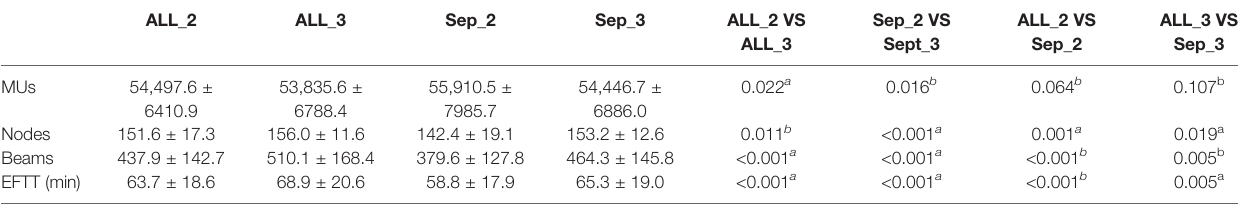
a Comparison by paired samples t-test. b Comparison by Wilcoxon signed-rank